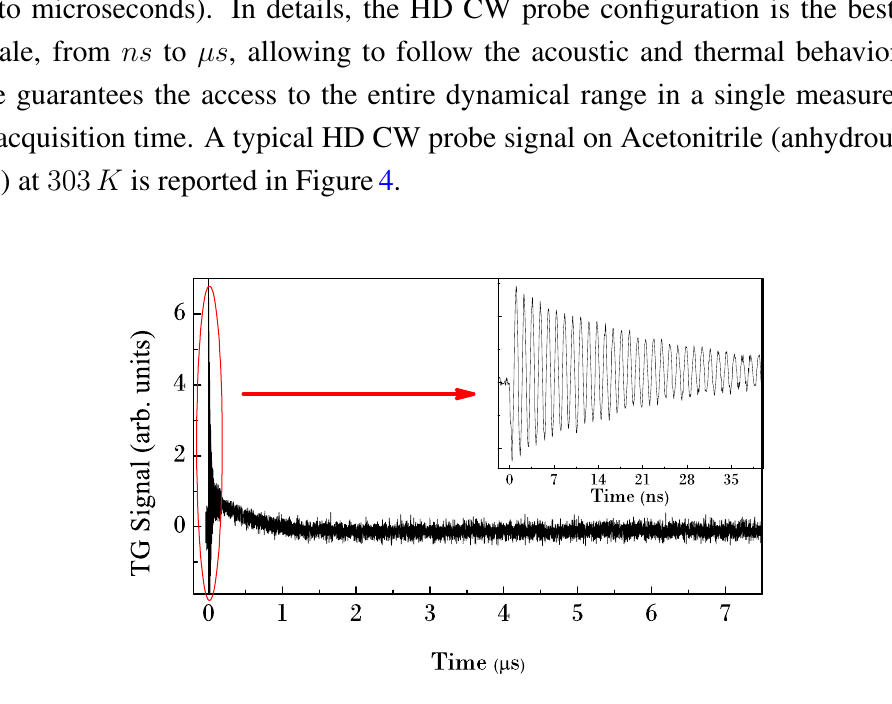
Figure 4. Heterodyne detected TG signal from acetonitrile at 303 K . The inset shows a zoom at short time, where damped acoustic oscillations are